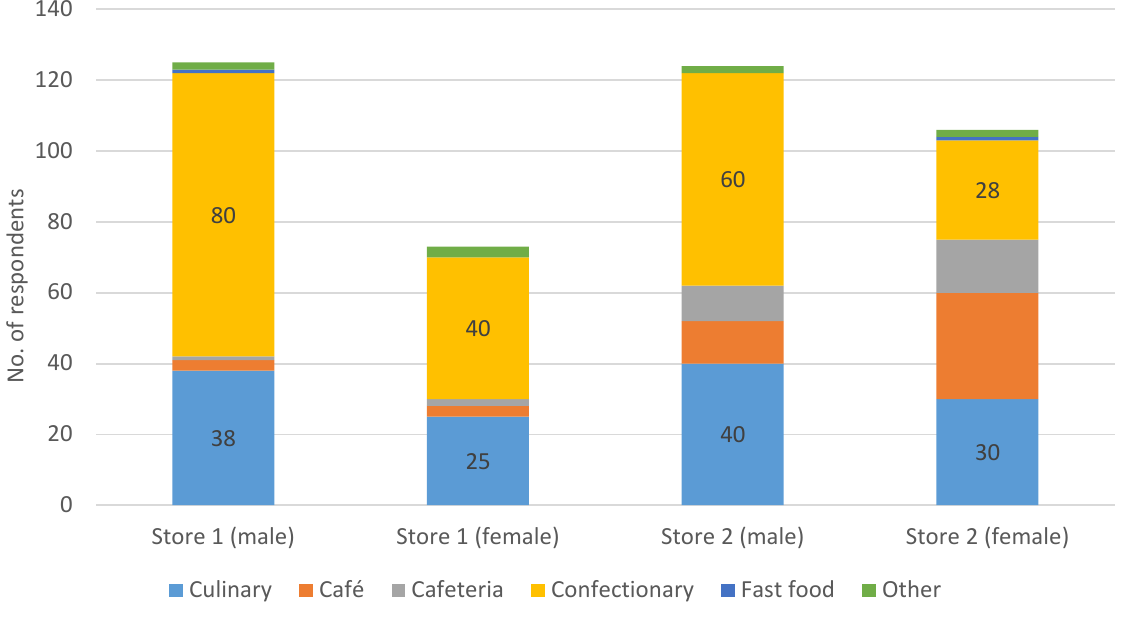
Figure 1. Distribution of the respondents by associative perceptions of a store